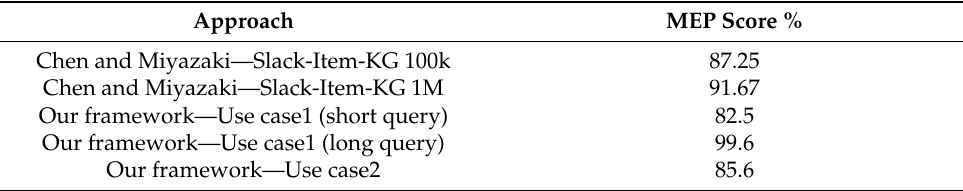
Table 4. Explainability comparison based on the MEP scores. Approach MEP Score